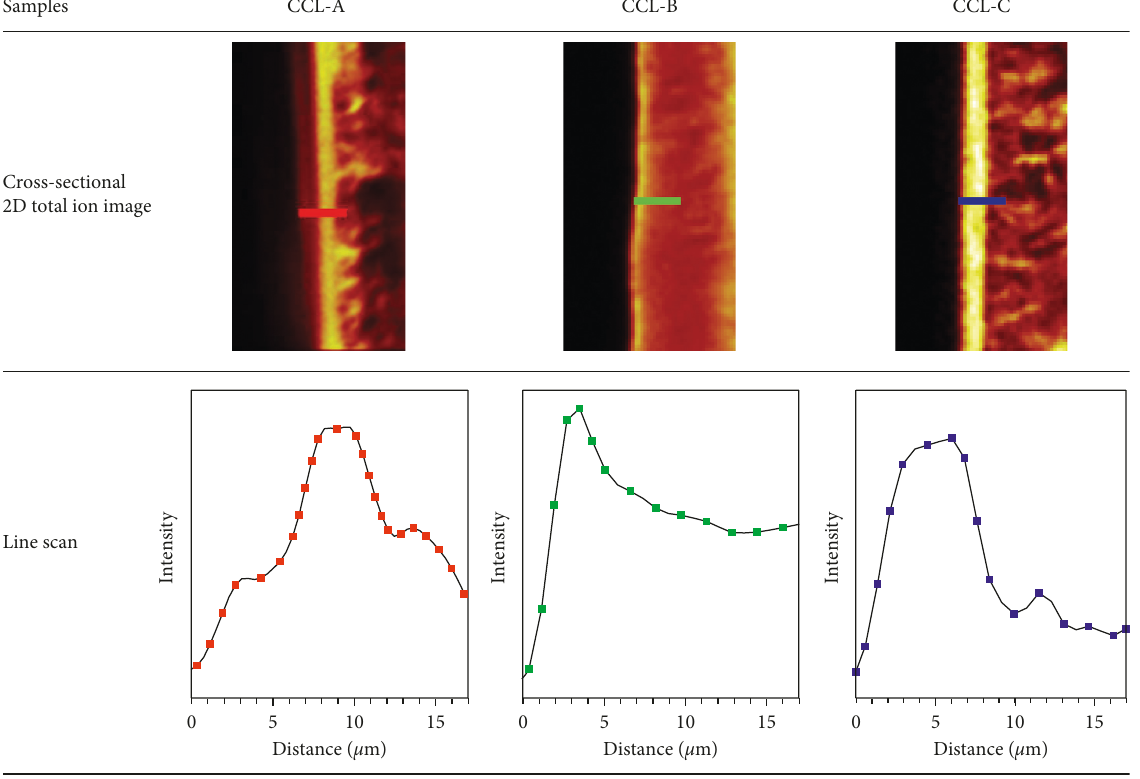
Figure 6: ToF-SIMS results of cross-sectional 2D image mapping and line scan of the surface layer for lenses CCL-A, CCL-B, and CCL-C.